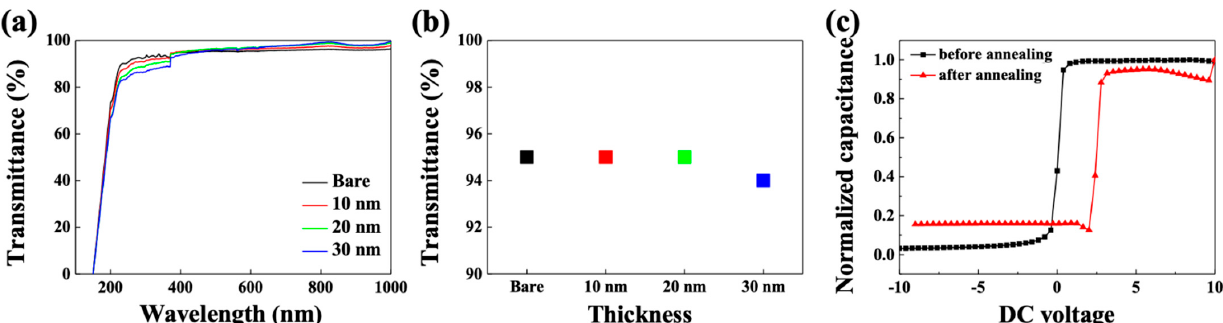
Figure 3. ( a ) Light transmittance for 200 to 1000 nm range of ALD-grown Al 2 O 3 thin films with various thicknesses. ( b ) Average light transmittance with respect to the thickness of the Al 2 O 3 layer. ( c ) Capacitance-voltage profile of a p-type single-crystalline silicon wafer passivated by the ALD-grown 10 nm Al 2 O 3 thin layers.